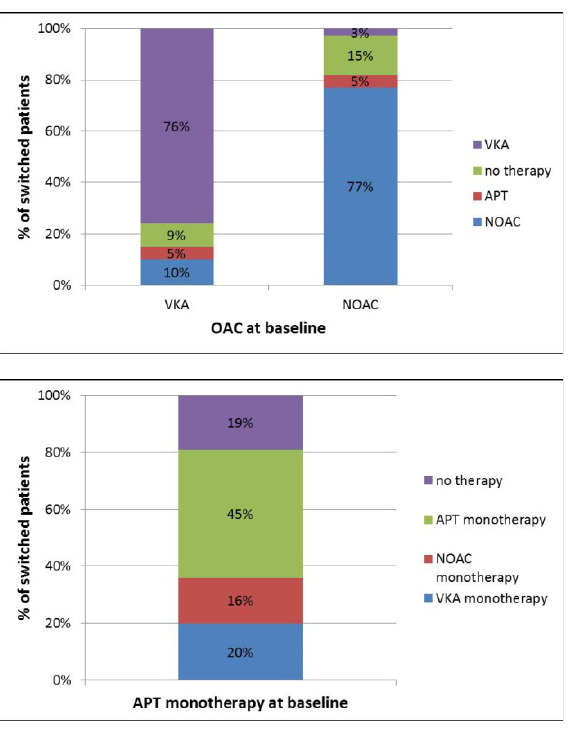
Figure 6: Switch of oral anticoagulation over time (percentage of switched patients over the follow-up period by type of baseline anticoagulation). APT = antiplatelet therapy; NOAC = non-vitamin K antagonist oral anticoagulant; VKA = vitamin K antagonist.